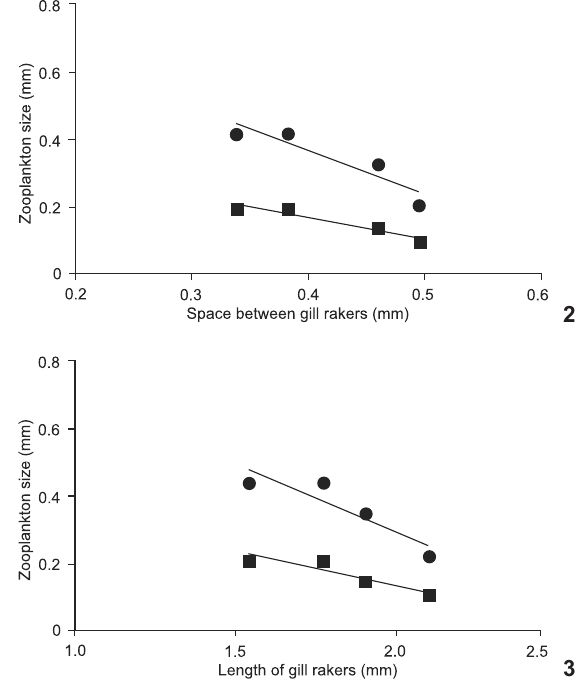
Figures 2-3. (2) Negative correlation between zooplankton’s body size found in stomach contents and space between Nile tilapia’s gill rakers. Significant Pearson’s correlation (Length r = -0.92 and p = 0.07; Width r = -0.96 and p = 0.04). (3) Negative correlation between zooplankton’s body size found in stomach contents and length of Nile tilapia’s gill rakers. Significant Pearson’s correlation (Length r = -0.91 and p = 0.09; Width r = -0.92 and p = 0.08). ( (cid:122) ) Length, ( (cid:132) )